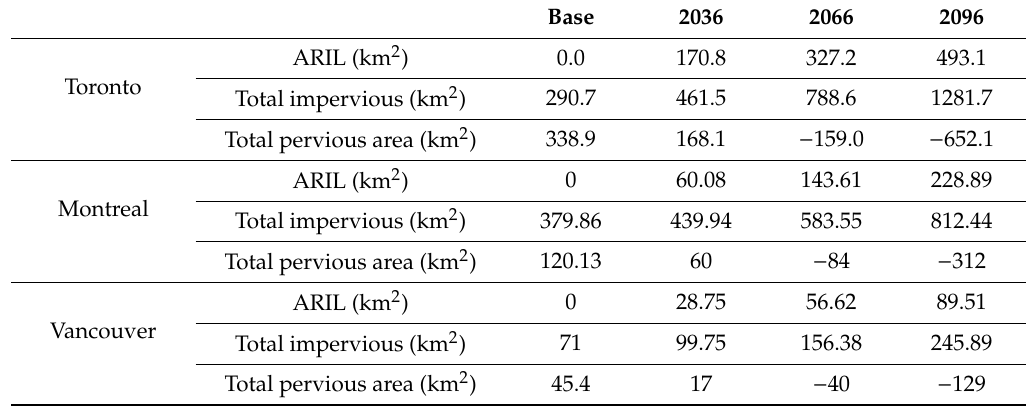
Table 8. Land cover data of Toronto, Montreal, and Vancouver on the base year (2007, 2016, and 2014, respectively for each city) and its projected changes due to the urban growth in years 2030, 2066, and 2096.